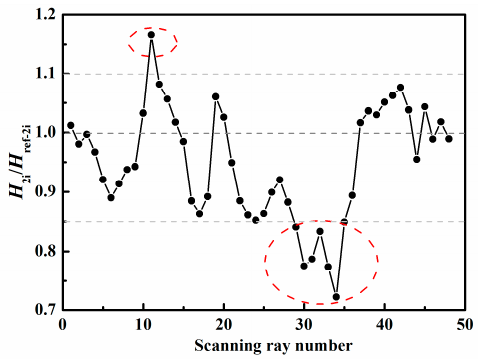
Figure 9. Determination of threshold values for ray paths to upper-left corner.